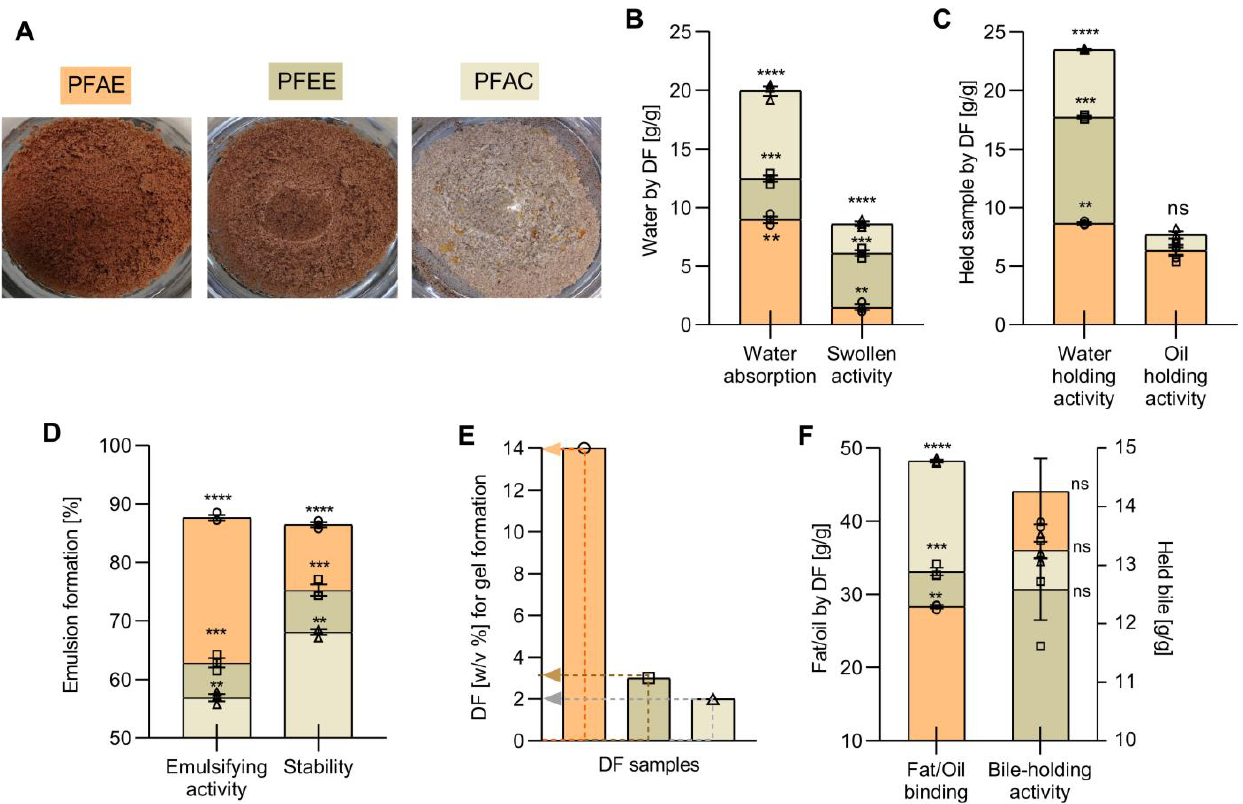
Figure 1. ( A ) Dietary fiber (DF) obtained from persimmon byproduct by aqueous extraction (PFAE, ○ ), ethanolic extraction (PFEE, □ ) and acetonic extraction (PFAC, △ ). Solvent assisted extraction (SAE) effect on techno-functional properties of persimmon fiber (PF); ( B ) hydration properties, ( C ) holding properties; ( D ) emulsifying properties, and ( E ) gel formation activity (GFA). ( F ) Solvent effect on physio-functional properties of PF (**** p < 0.0001, *** p < 0.001, ** p < 0.01, ns p > 0.05, ANOVA with Tukey’s post hoc test).